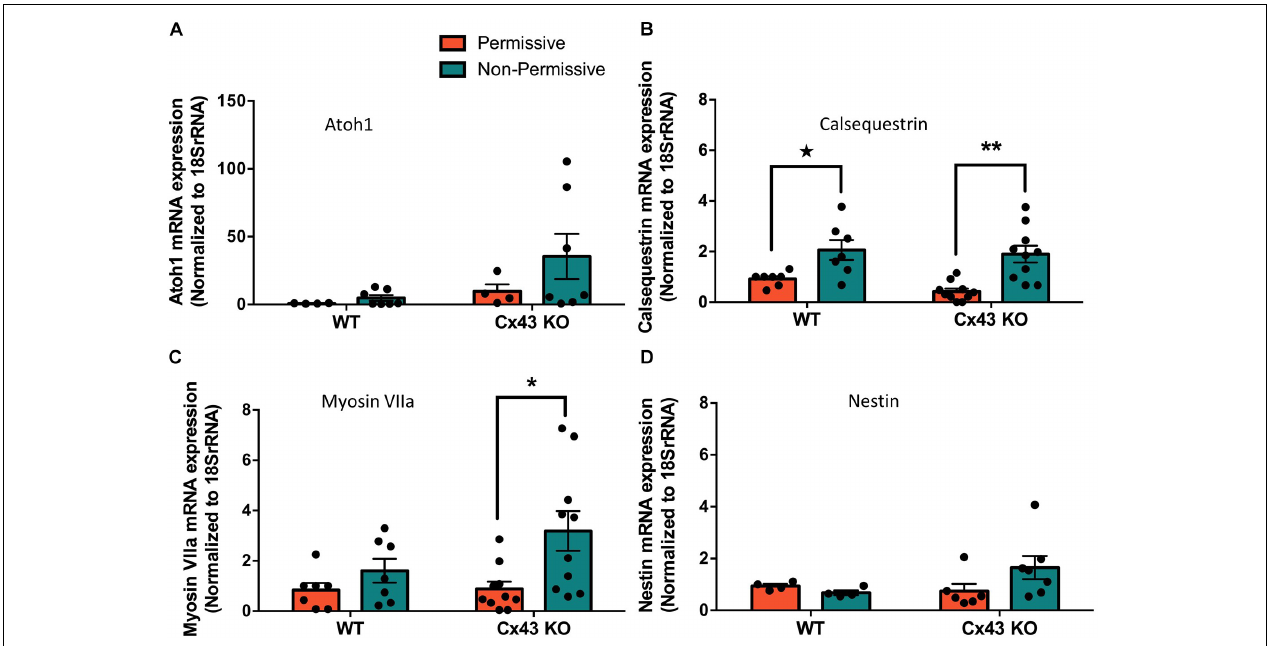
FIGURE 9 | Partial differentiation of HEI-OC1 cells in non-permissive cultures was independent of Cx43 status. (A) Real-time qPCR normalized to 18SrRNA revealed that Atoh1 mRNA levels were unchanged when wild type (WT) or Cx43 KO cells were grown for 10 days in non-permissive conditions. (B) WT and Cx43 KO cells exhibited increased calsequestrin mRNA levels when cultured in non-permissive conditions, and (C) Cx43 KO cells had higher myosin VIIa mRNA levels. (D) The progenitor cell marker nestin mRNA expression was unaltered under any conditions tested. Data represent mean ± SEM of four independent experiments comprised of two independent Cx43 KO clones. (* p < 0.05, ** p < 0.01 two-way ANOVA and Tukey’s post hoc , (cid:72) p < 0.05 unpaired t